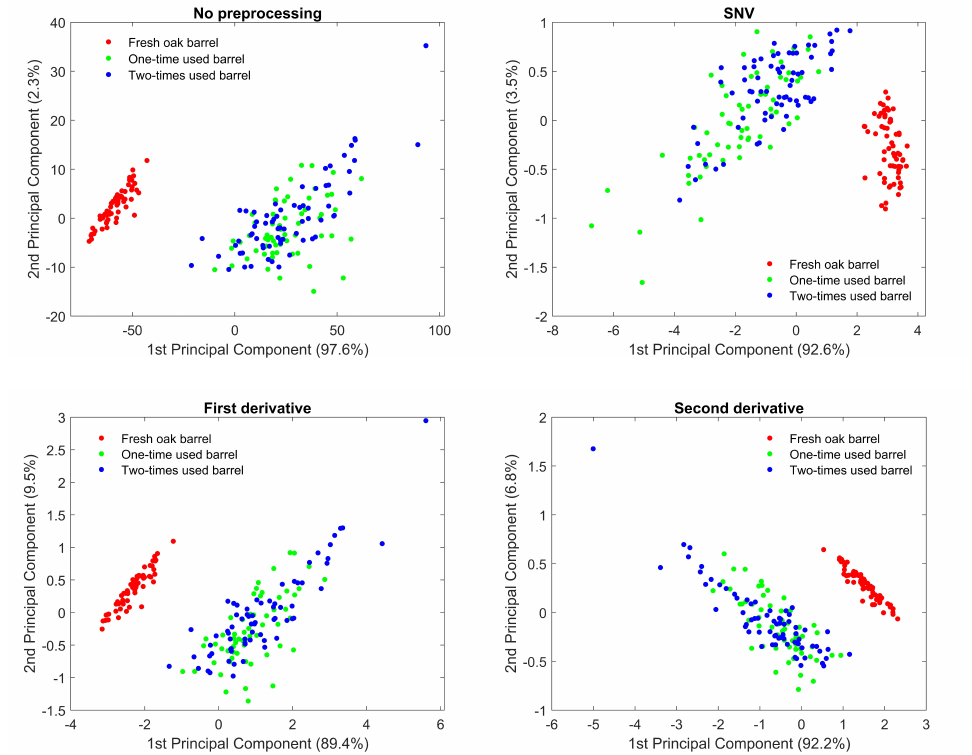
Figure 5. Scatter plot of the first 2 principal components using PCA. The amount of variance explained is written in between brackets on the axis labels. The separation between one– and two–times–used barrels was not possible using the 2 first components, as could already be expected from the variable and overlapping raw fluorescence data. Table 2. Classification results using fluorescence spectroscopy. The optimal number of PLS or PCA components is denoted in brackets. The validation accuracy is given in the table, obtained by using repeated (nested) 5-fold cross-validation. The error is the standard error of the mean obtained by the 10 different